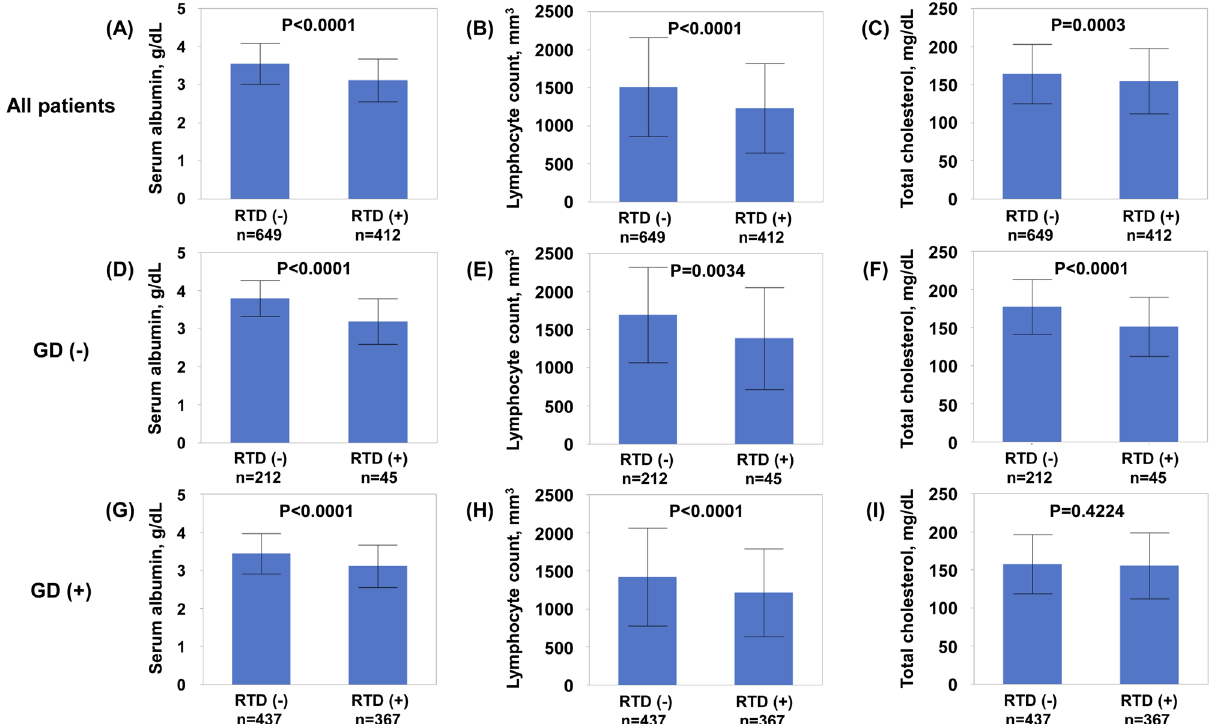
Figure 2. Association between controlling nutritional status score components and RTD in all heart failure patients ( A–C ), in heart failure patients without GD ( D–F ), and in heart failure patients with GD ( G–I ). GD glomerular damage, RTD renal tubular